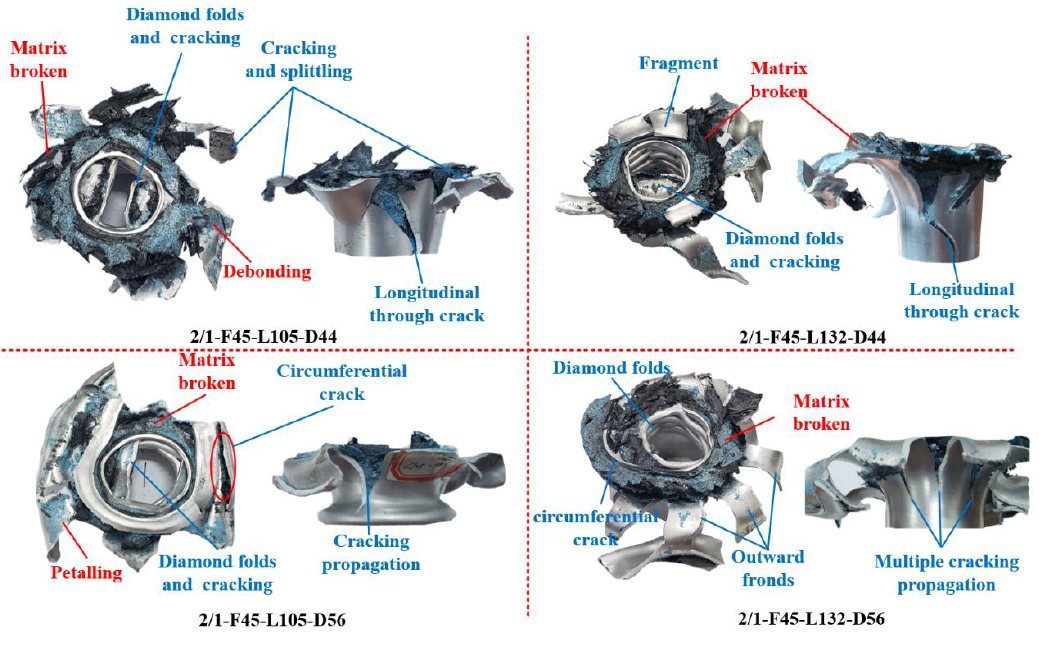
Figure 12. Final failure modes of 2/1 hybrid tubes with [45 ◦ / − 45 ◦ ] lay-up sequence.